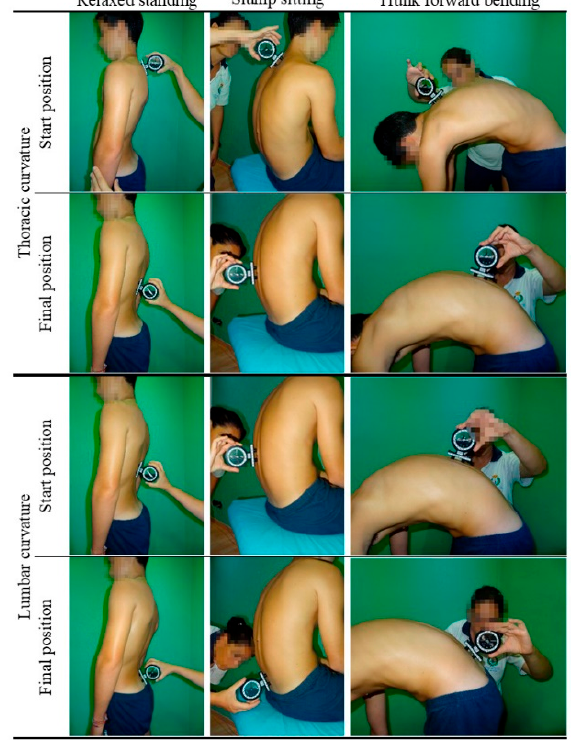
Figure 1. Thoracic and lumbar sagittal curves assessment tests.